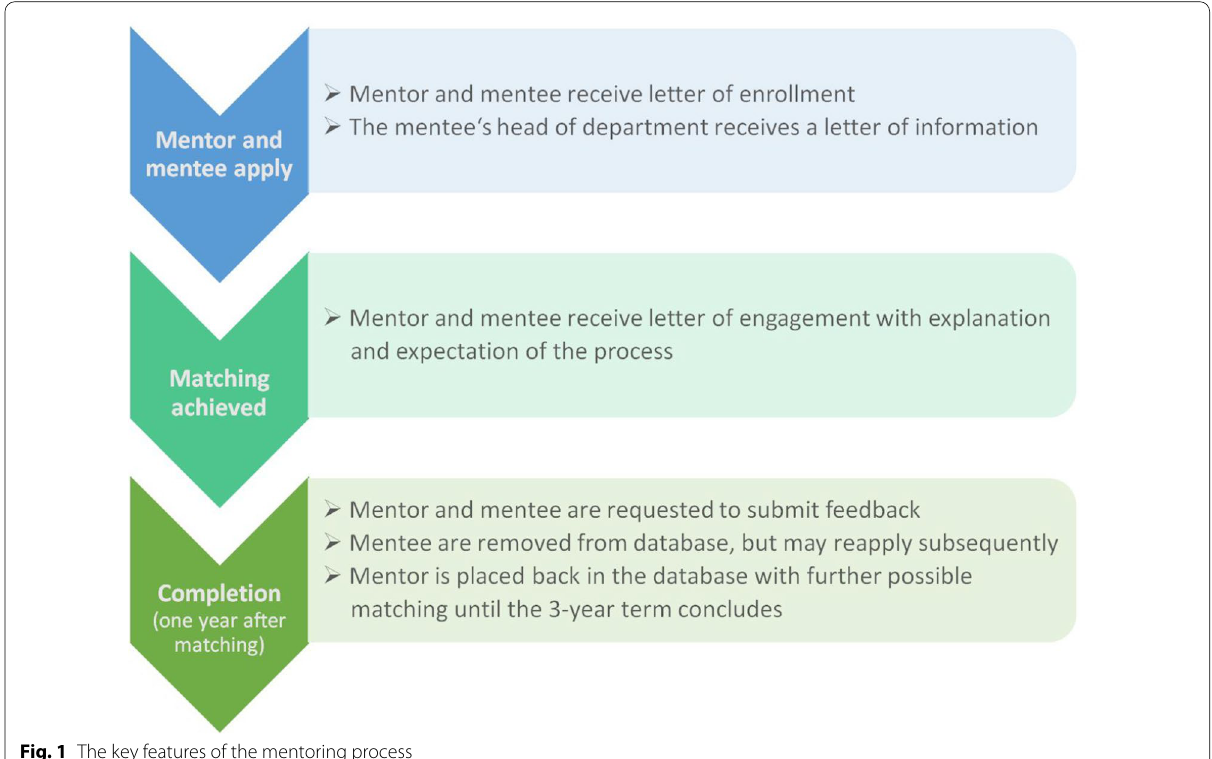
Fig. 1 The key features of the mentoring process